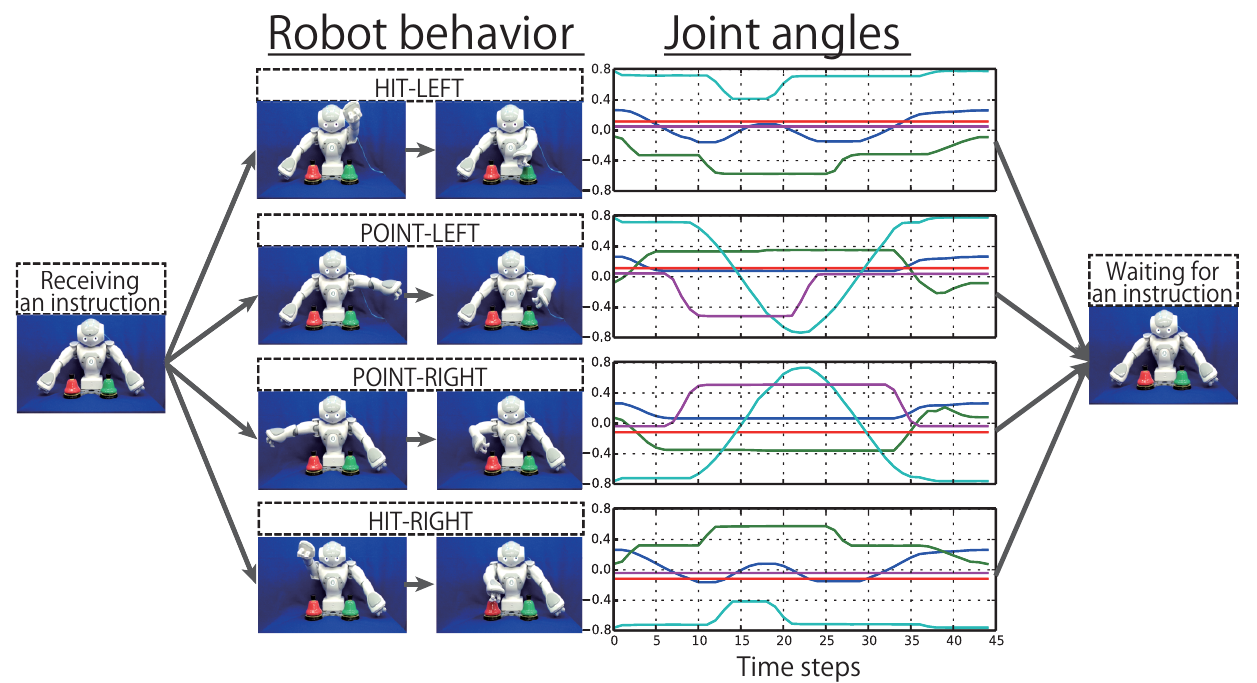
FIGURE 3 | The behaviors to be generated by the robot responding to the human’s instructions . Each behavior is generated either “SLOWLY” or “FAST,” which take approximately 45 and 30 time steps, respectively. For each behavior, only the five joint angles on the moving arm are plotted.